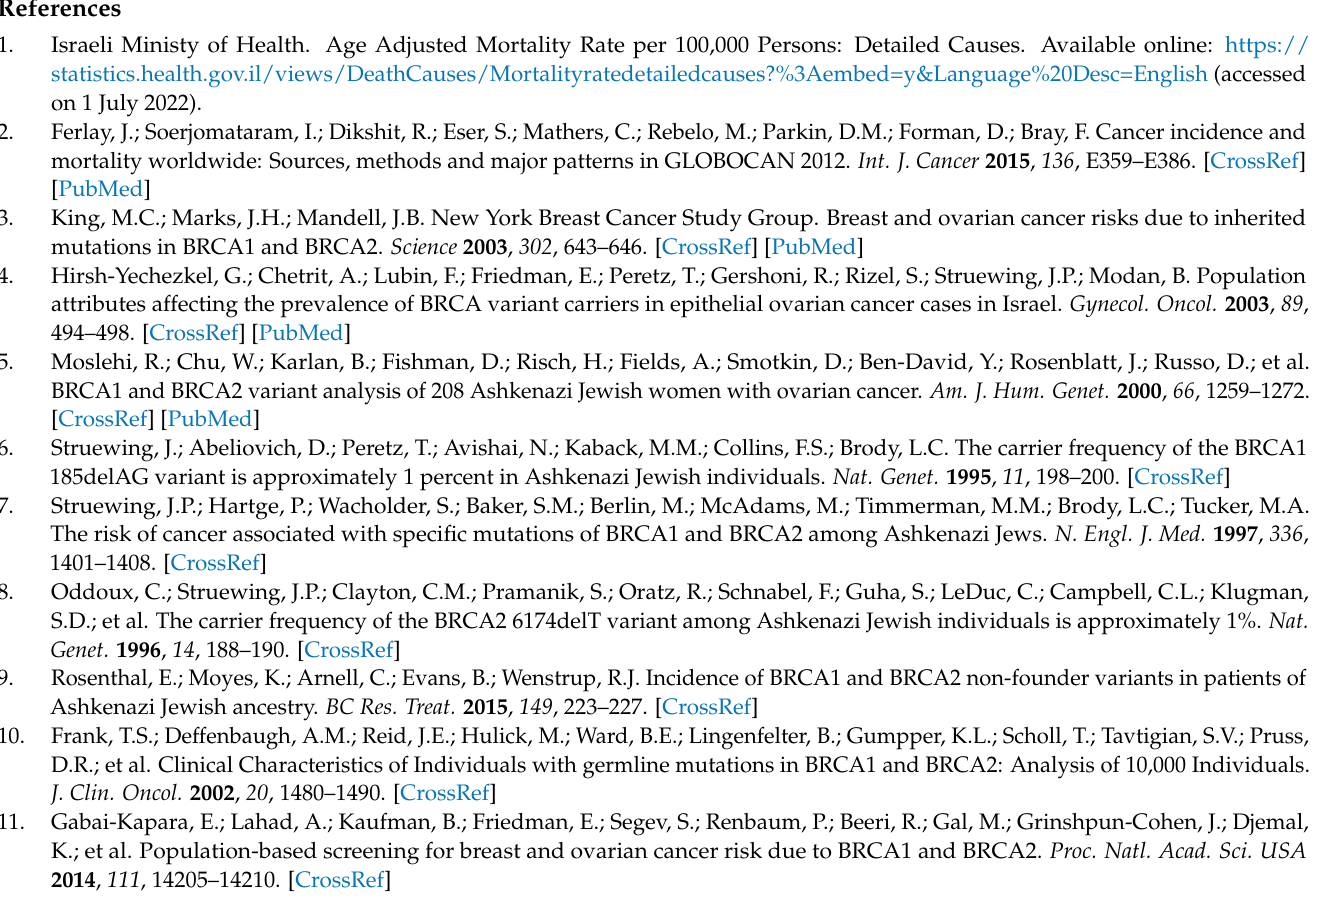
Table S5: One way sensitivity analysis for genetic testing costs: PS vs. CT strategies, Figure S1: Incremental effectiveness scatterplot, PS vs.